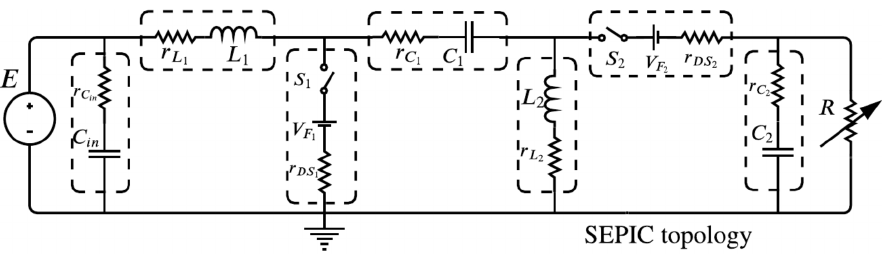
Figure 3. Electrical schemes of nonideal SEPIC DC-DC